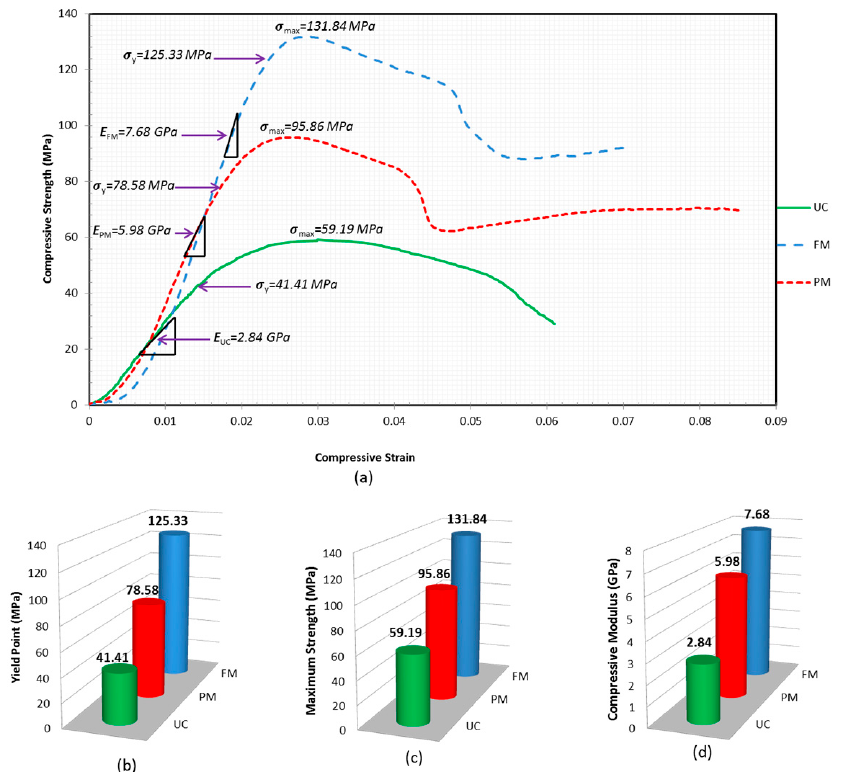
Figure 9. Compressive modulus, yield point, and maximum strength of every test sample. ( a ) Stress versus strain diagram of test samples with maximum strength. ( b ) Bar chart for compressive modulus value. ( c ) Bar chart for yield stress value. ( d ) Bar chart for maximum stress value.